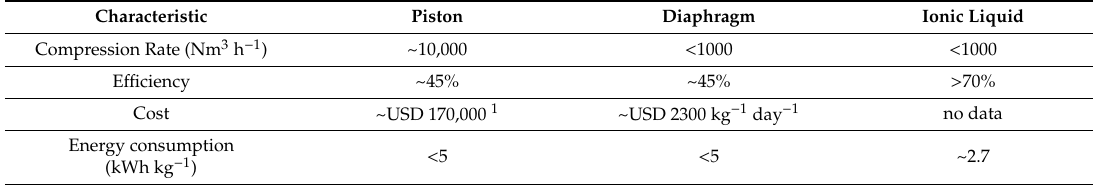
Table 1. Main characteristics of mechanical hydrogen